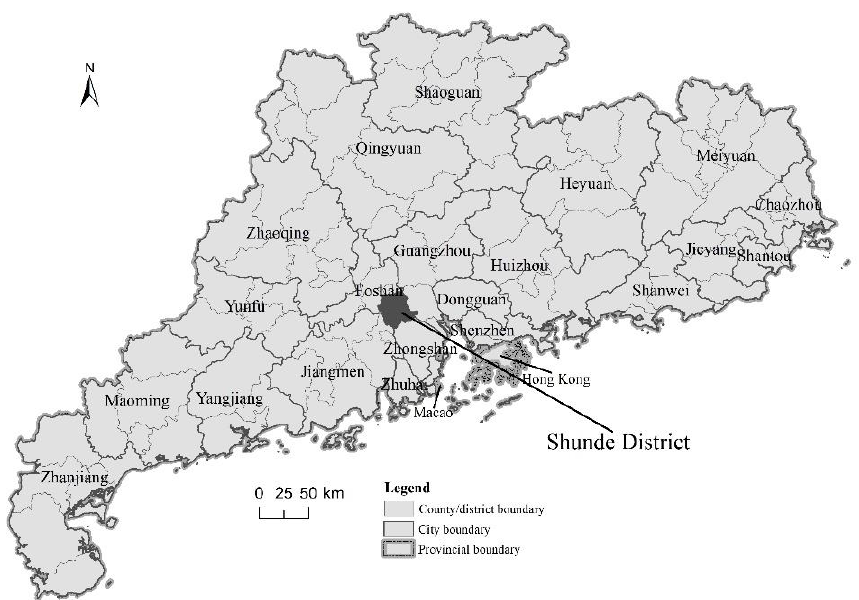
Figure 4. Location of Shunde District in Guangdong Province.